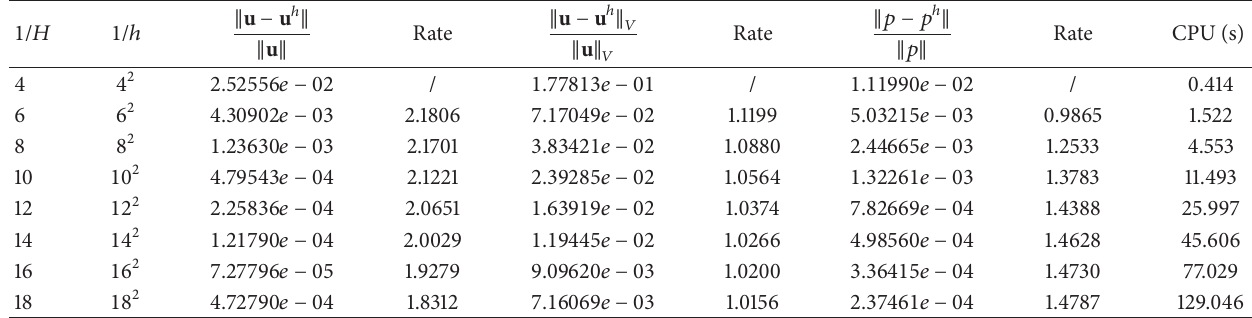
Table 2: Convergence of two-level Newton iteration